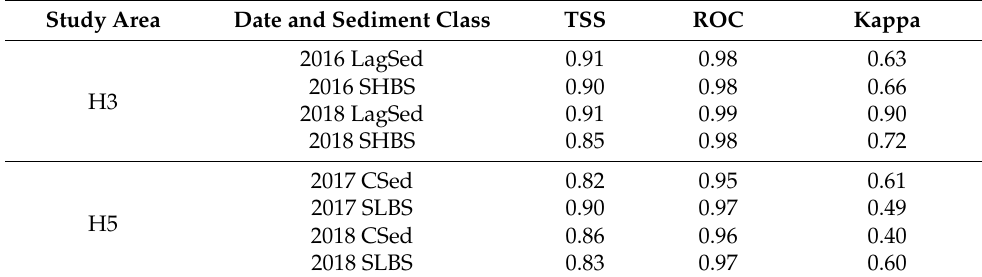
Table 5. Performance score of the committee-averaged ensemble models for H3 and H5 according to their TSS, ROC and Kappa. Only models with TSS > 0.7 from the single model runs were included in the ensemble